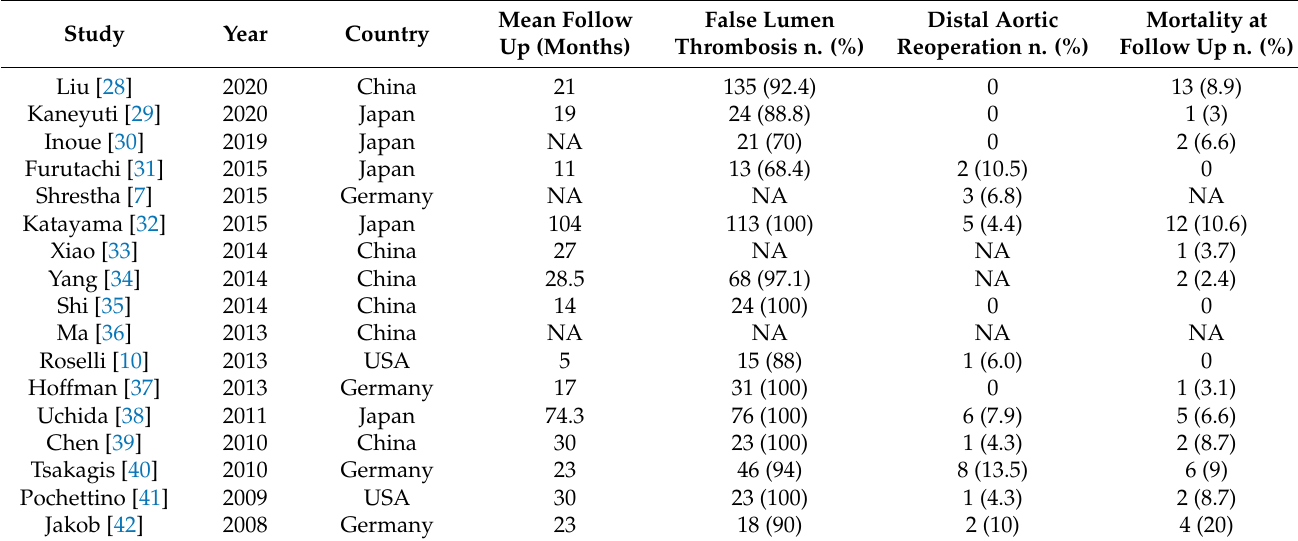
Table 2. Outcomes at follow-up after extensive ATAAD repair with the FET technique.